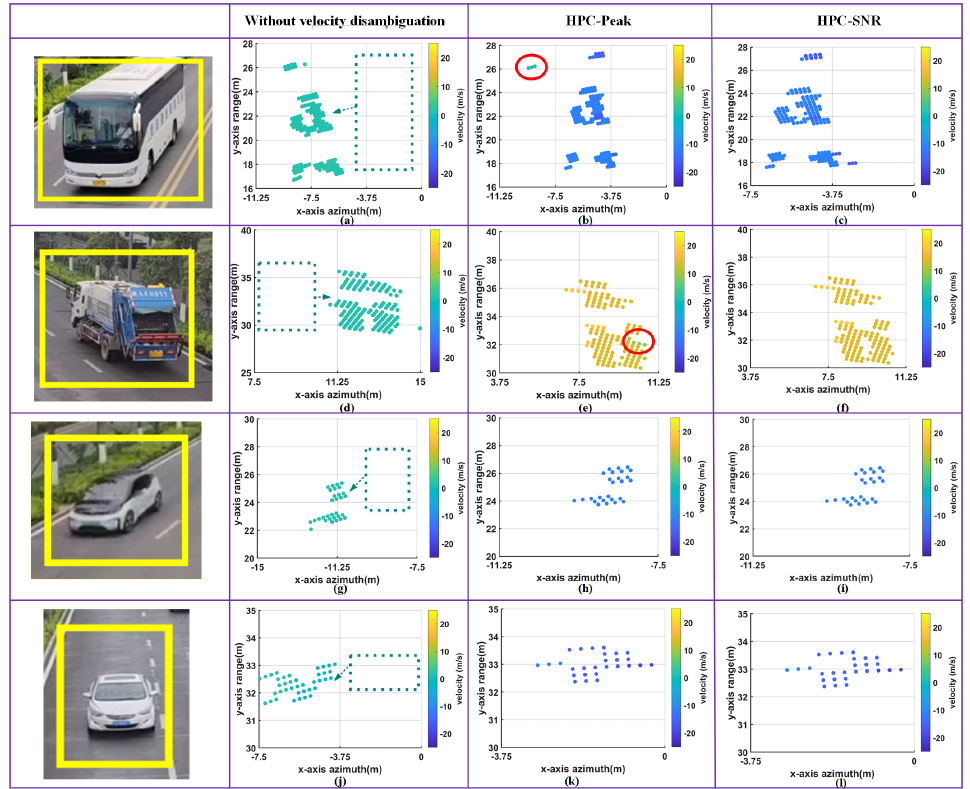
Figure 23. Velocity disambiguation test. ( a ) Without velocity disambiguation in vehicle 1 case. ( b ) The HPC-Peak algorithm test result in vehicle 1 case. ( c ) The HPC-SNR algorithm test result in vehicle 1 case. ( d ) Without velocity disambiguation in vehicle 2 case. ( e ) The HPC-Peak algorithm test result in vehicle 2 case. ( f ) The HPC-SNR algorithm test result in vehicle 2 case. ( g ) Without velocity disambiguation in vehicle 3 case. ( h ) The HPC-Peak algorithm test result in vehicle 3 case. ( i ) The HPC-SNR algorithm test result in vehicle 3 case. ( j ) Without velocity disambiguation in vehicle 4 case. ( k ) The HPC-Peak algorithm test result in vehicle 4 case. ( l ) The HPC-SNR algorithm test result in vehicle 4